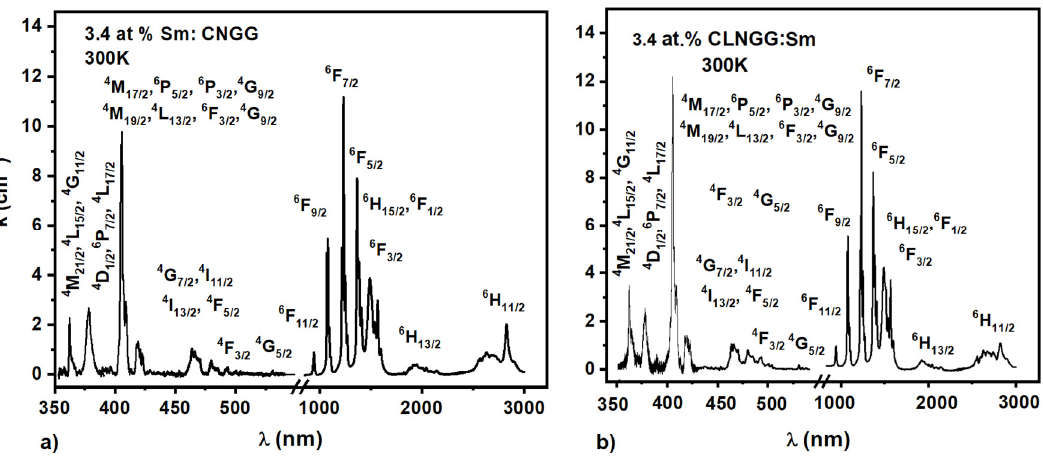
Figure 3. Absorption spectra at room temperature of Sm 3+ ions in CNGG:Sm ( a ) and CLNGG:Sm ( b ) crystals.